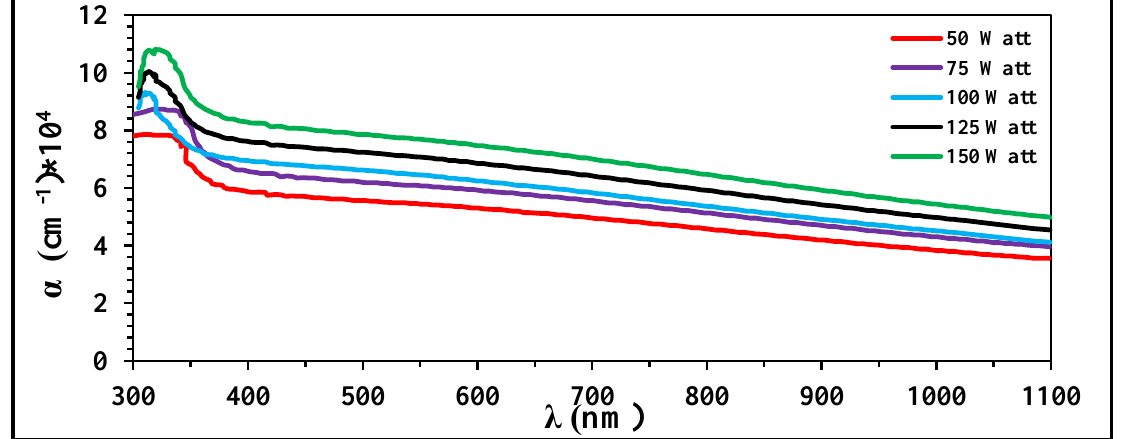
Fig. 4: Absorption coefficient as a function of wavelength for (Ti6Al4V) thin film at different working RF